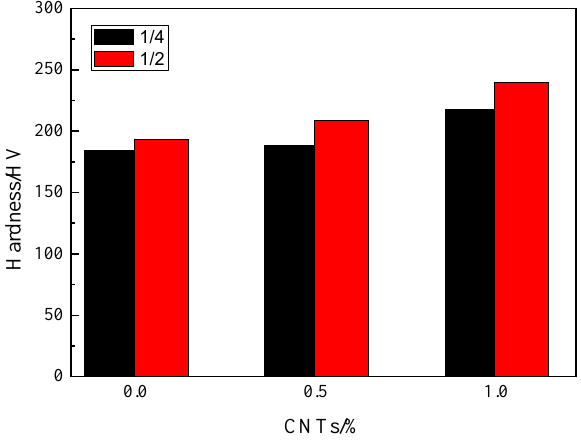
Table 2. Microhardness of the composites with different CNT contents.